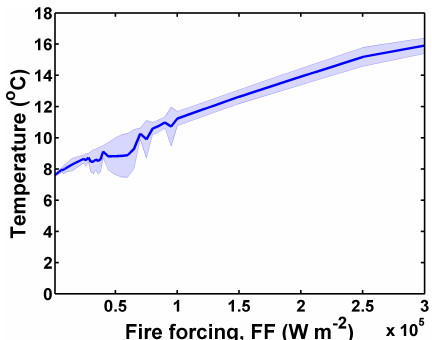
Figure 5. The correlation of fire forcing and the corresponding max- imum temperature at cloud base. The shaded area indicates the vari- ability of estimation ( ± 0.5 σ ) over each simulation